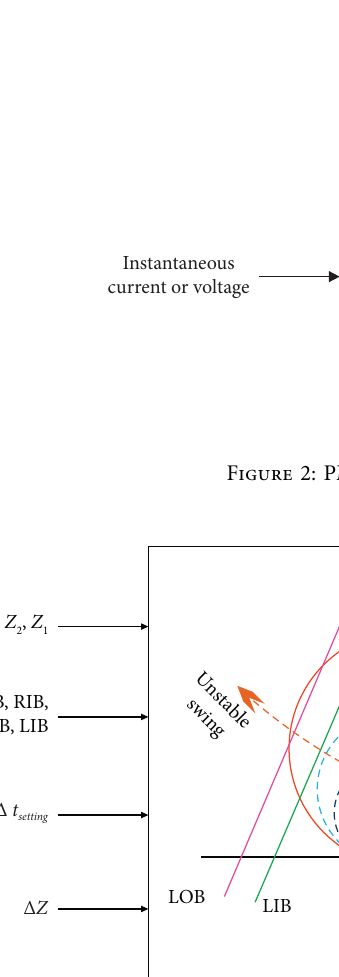
Figure 3: Blinder